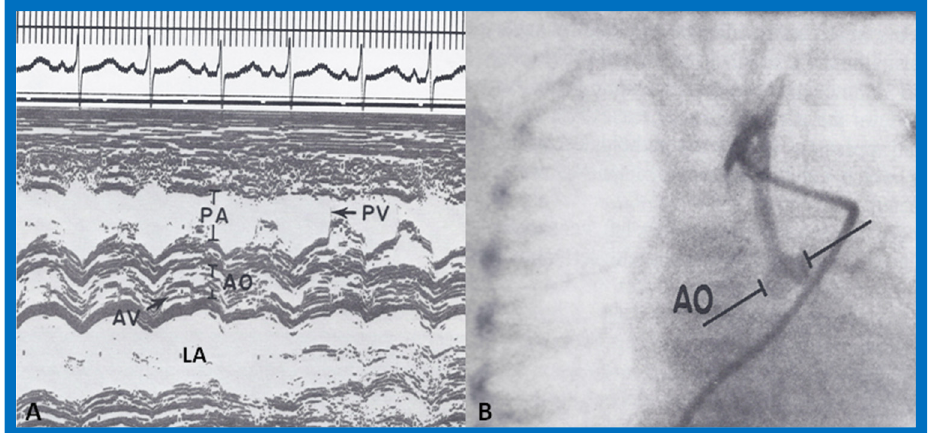
Figure 10. ( A ) Selected M-mode recordings from the parasternal short axis view of the left atrium (LA), aorta (Ao), and pulmonary artery (PA), demonstrating near normal sized aorta in a baby with hypoplastic left heart syndrome. ( B ) Selected cine frame from aortic arch angiogram in